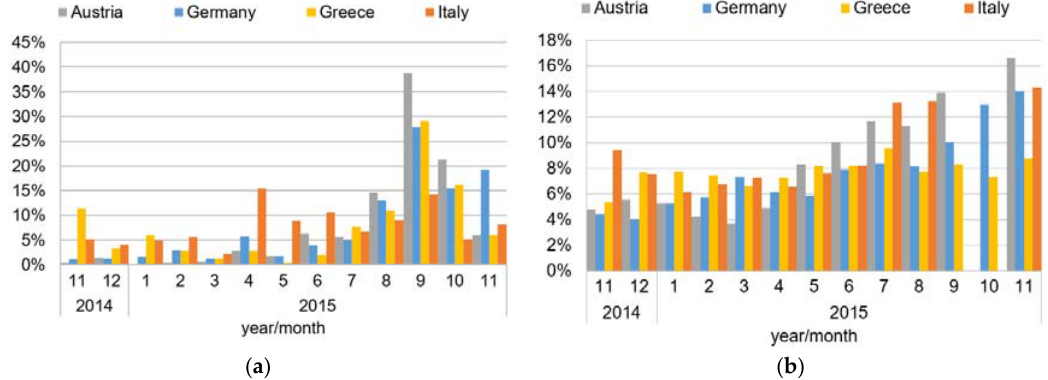
Figure 11. Monthly proportion of refugee related tweets for Austria, Germany, Greece, and Italy out of all refugee related tweets over a 13 month period for each country ( a ); and monthly proportion of asylum seekers for each country out of all registered asylum seekers over the same 13-month period for each country, based on UNHCR data [46] ( b ).